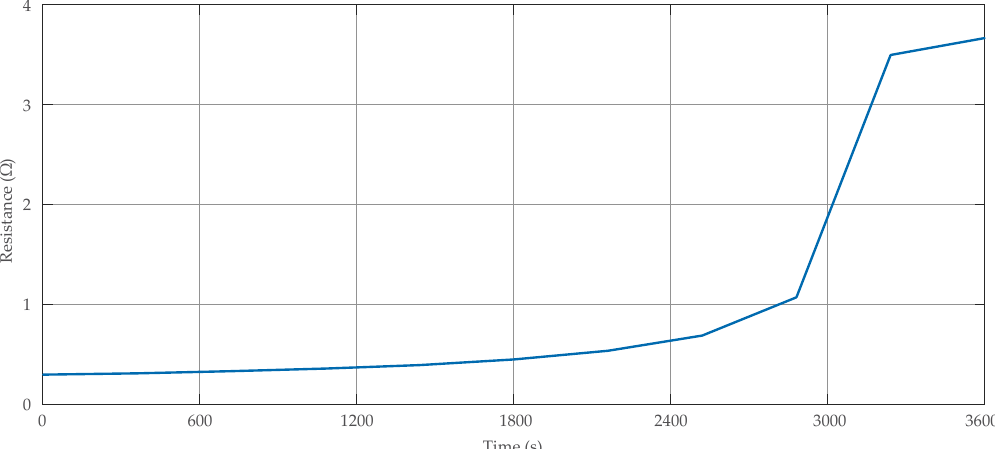
Figure 11. Behaviour of the resistance R 1 for a Li-Po cell according to the V OC and V (cid:48)